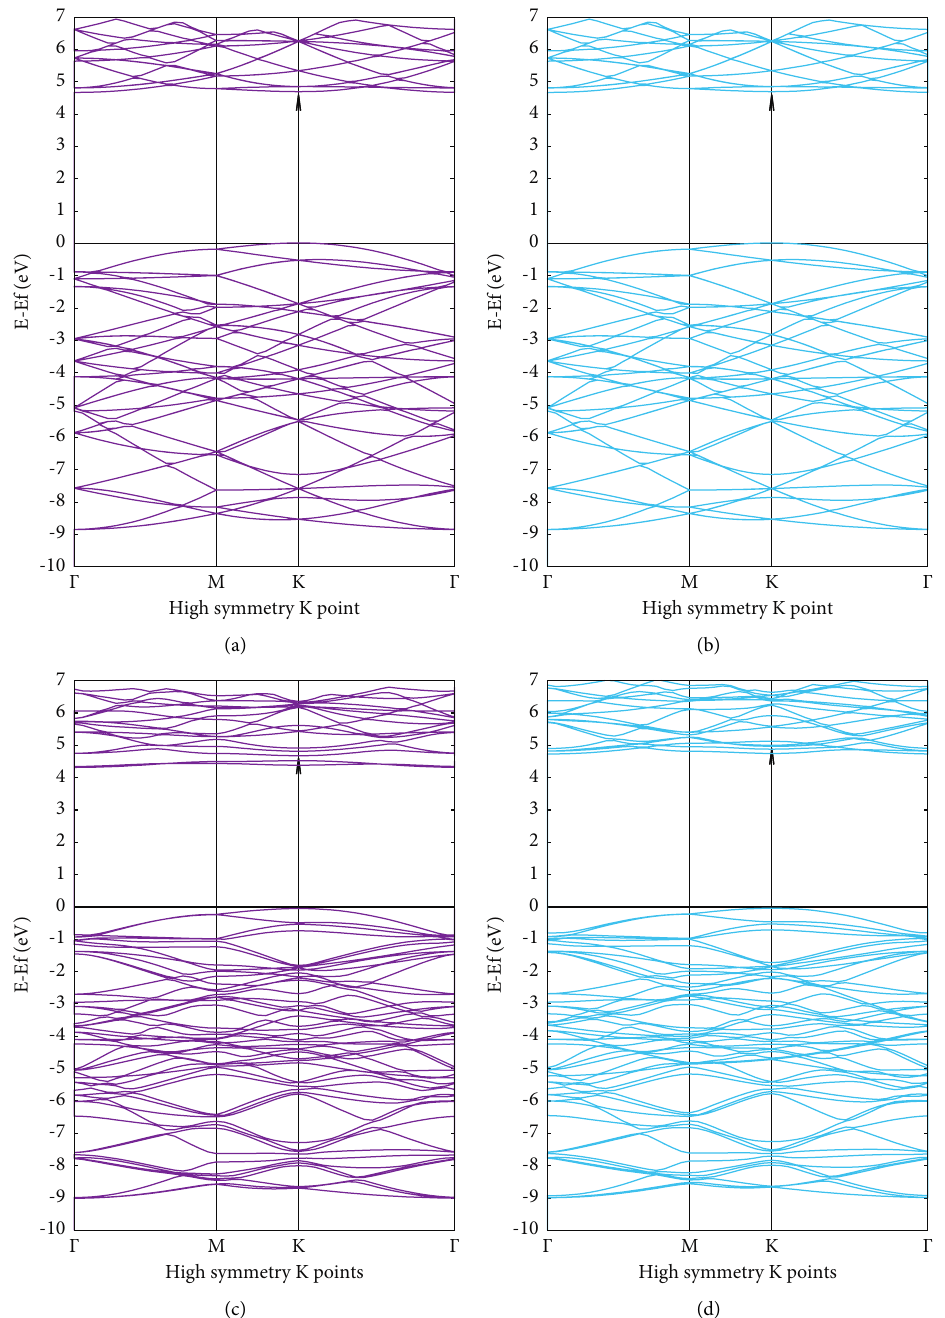
Figure 4: Calculated band structures of 4 × 4 × 1 monolayer BN supercell. (a)-(b) Pure. (c)-(d) Single Si-doped. The blue-violet and blue lines represent the spin-up and spin-down components, respectively, and zero-energy represents the Fermi level. Table 2: The calculated magnetic energy ( △ E � E − E ) and magnetic moment ( μ ) for silicon-doped monolayer boron nitride. B FM AF System E (eV) FM Pure supercell — — —